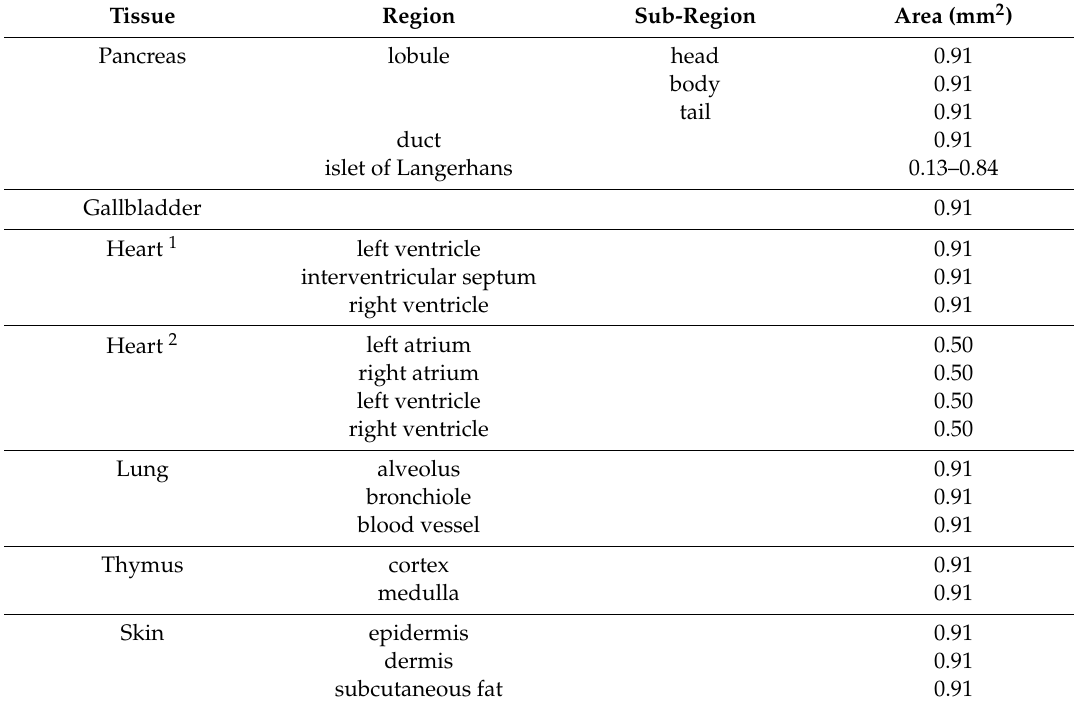
Table 1. Summary of tissue samples in the